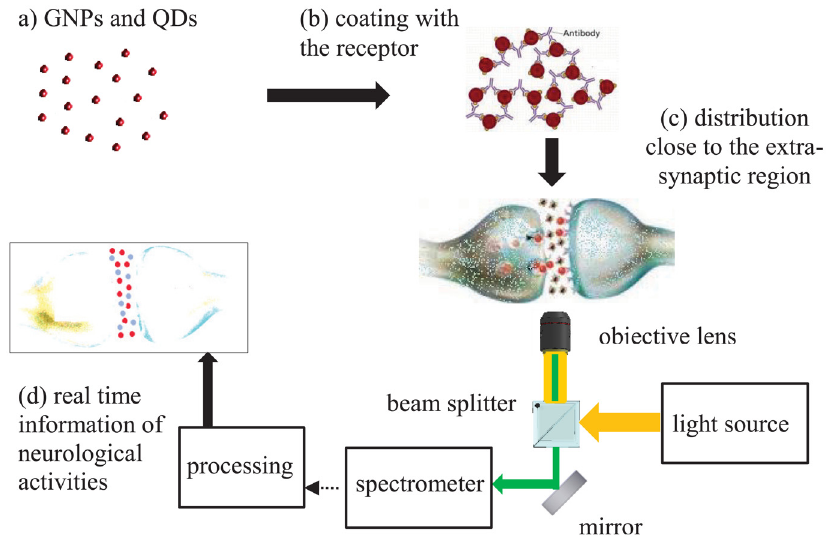
Fig 2. The proposed concept of optical real time imaging of neural activities using functionalized resonant nano-structures. Figure is drawn by